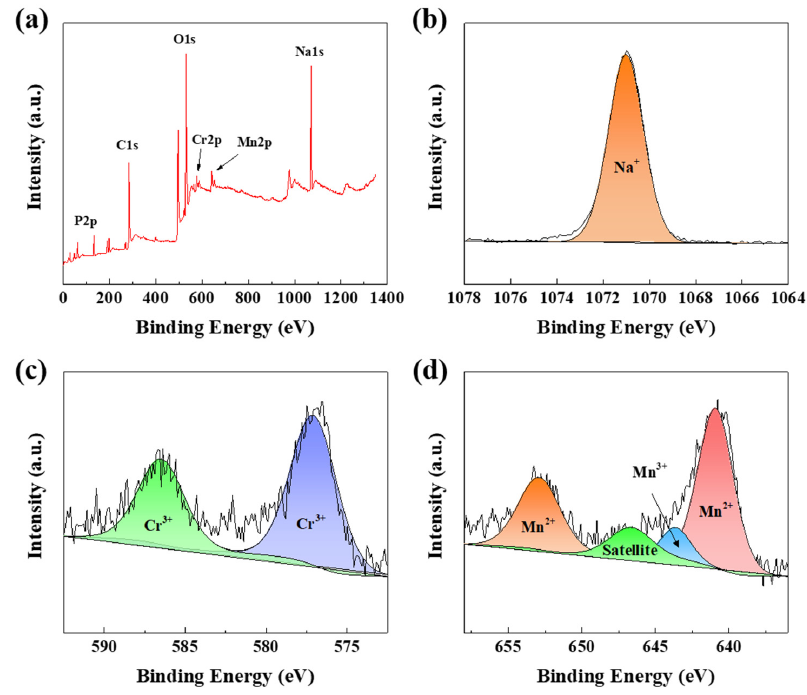
Figure 5. XPS spectra of ( a ) survey, ( b ) Na 1s, ( c ) Cr 2p, and ( d ) Mn 2p of